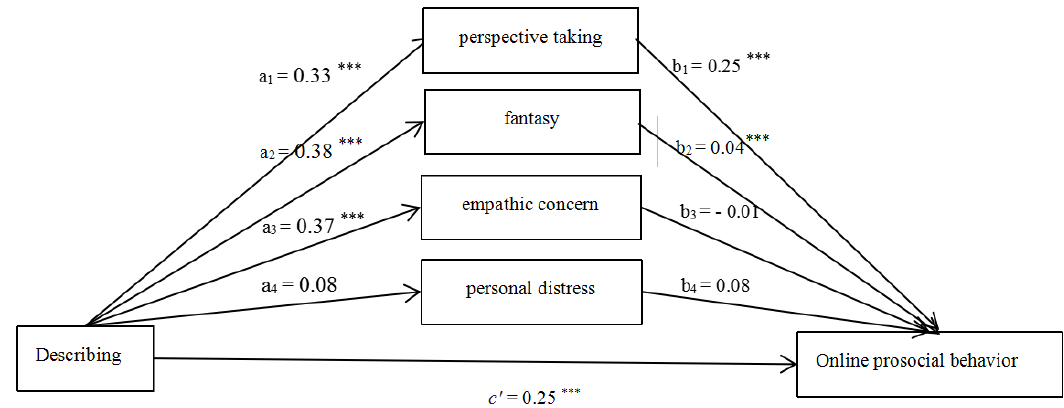
Figure 2. Mediating roles of empathy components (Describing as the predictor). Note: *** p < 0.001.